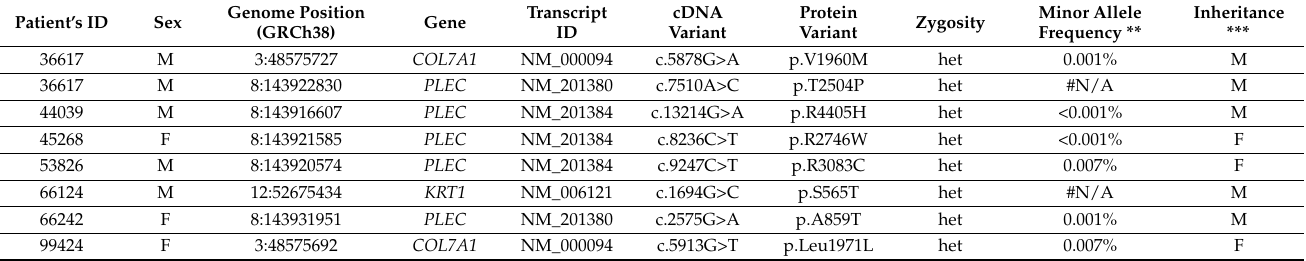
Table A1. Non-causal genome variants, revealed in examined patients